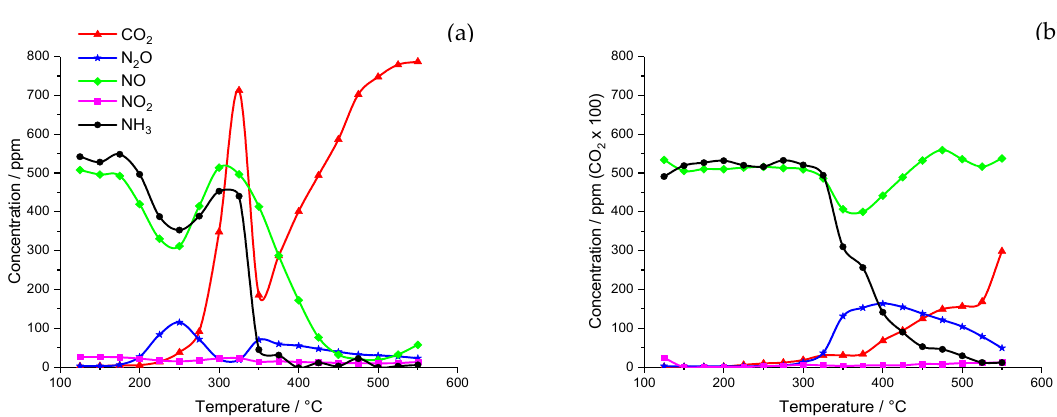
Figure 4. Reaction data for wet impregnation catalyst where the simulated exhaust gas consisted of 500 ppm NO, 500 ppm NH 3 , 8% O 2 , and N 2 as the balance gas. The temperature was increased in 25 °C intervals from 125–550 °C. (a) catalyst only reaction data, and (b) catalyst and soot reaction data. A total of 0.25 g of catalyst was mixed in a 10:1 ratio with soot to achieve loose contact. (Note difference in scales between (a) and (b) for CO 2 concentration.)